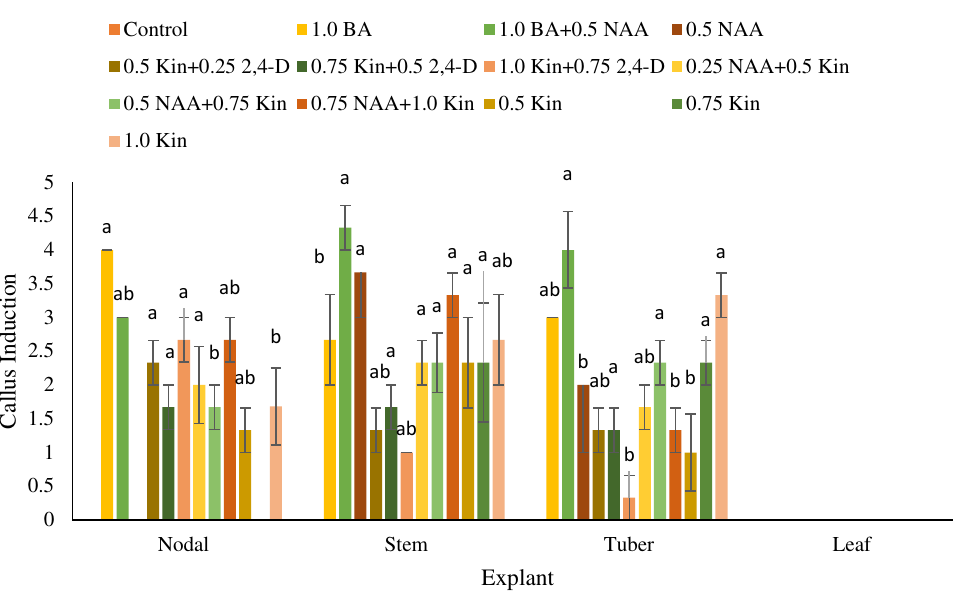
Figure 4. Effect of different concentrations of auxins (NAA and 2, 4-D) and cytokinins (BA and kinetins) on callus formation in different explants of P. erosus Values with the same label across different plant organs (explants) are not significantly different from each other at P≤ 0.05.